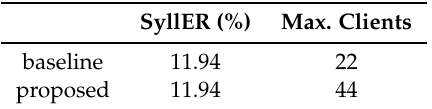
Table 7. Comparison of SyllER (%) and the multichannel performance of the Korean online ASR systems using the baseline and proposed acoustic score computation methods of BLSTM AM, with the test